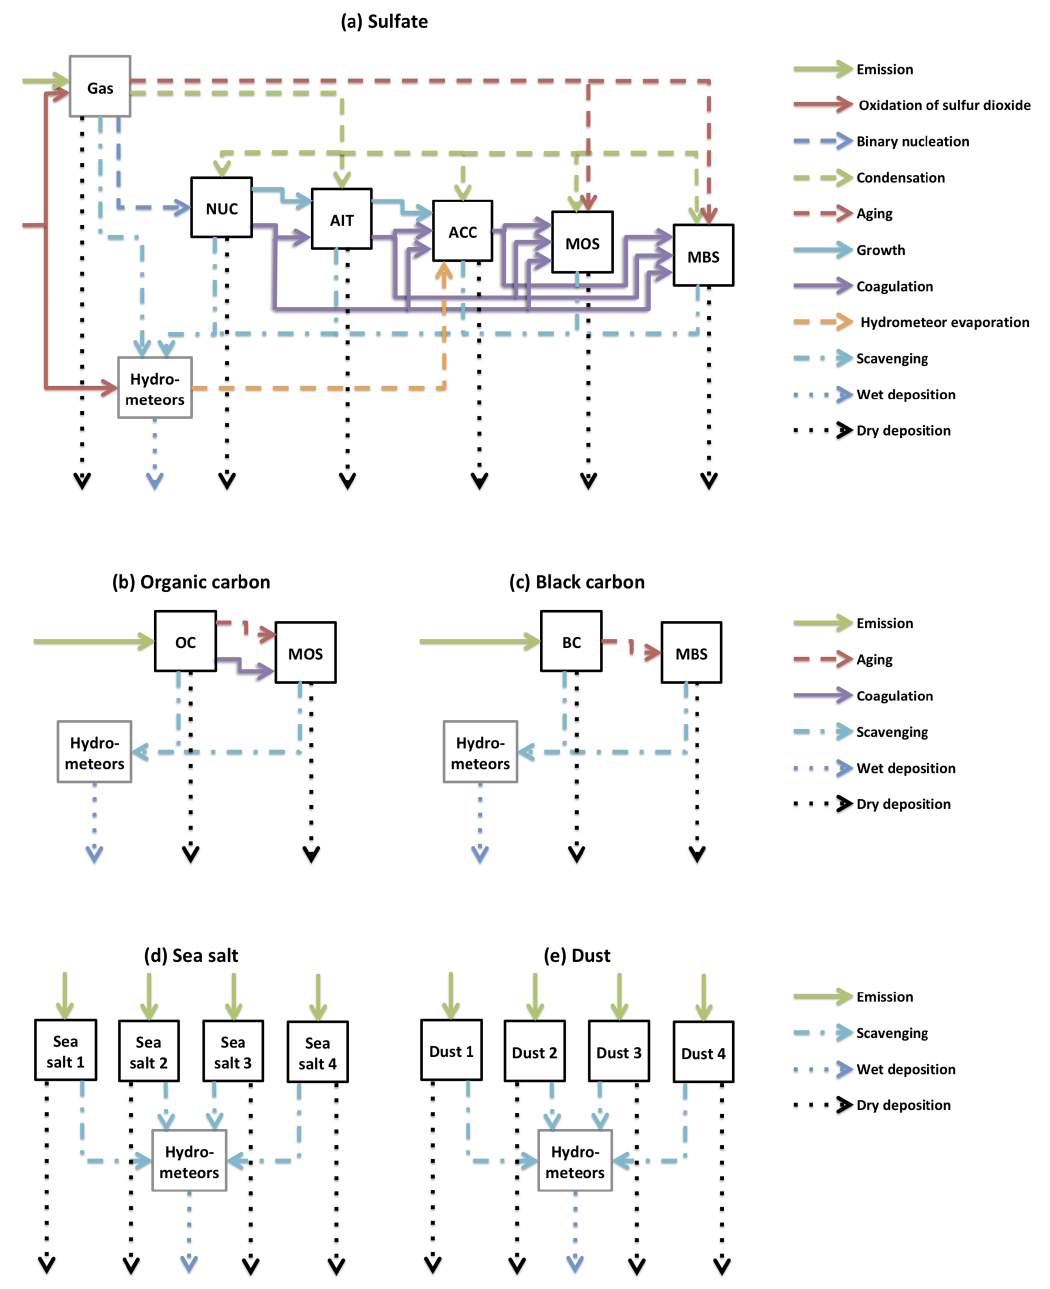
Figure 1. Physical and chemical processes represented by MARC, organised by chemical species: (a) sulfate, (b) organic carbon, (c) black carbon, (d) sea salt, and (e) mineral dust. Black boxes represent aerosol modes: nucleation-mode sulfate (NUC), Aitken-mode sulfate (AIT), accumulation-mode sulfate (ACC), internally mixed organic carbon plus sulfate (MOS), internally mixed black carbon plus sulfate (MBS), pure organic carbon (OC), pure black carbon (BC), four sea salt modes, and four mineral dust modes. Grey boxes represent non-aerosol states; sulfate can exist in the gas phase (as sulfuric acid), and all five chemical species can be scavenged by hydrometeors. The arrows illustrating physical and chemical processes are listed in the legend to the right of each row. Emission of sulfate (as gas-phase sulfuric acid) and oxidation of sulfur dioxide (including both gas-phase and aqueous processes) are handled by the sulfur chemistry scheme in CAM5.3. Emissions of OC include a contribution from volatile organic compounds. For sulfate, organic carbon, and black carbon, “scavenging” includes nucleation scavenging by stratiform clouds (handled by the aerosol-activation scheme) and nucleation scavenging by convective clouds (assuming a constant supersaturation of 0.1%) in addition to impaction scavenging; for sea salt and dust, “scavenging” refers to impaction scavenging only. “Dry deposition” includes gravitational settling. Further details are provided in Sect. 2.2 of this paper and Sect. 2.1 of Rothenberg et al.